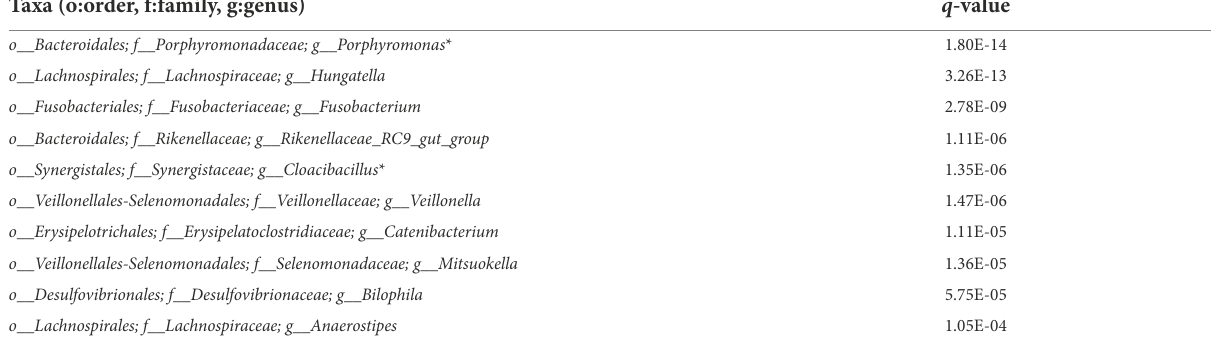
TABLE 5 Top 10 microbiome genera ranked by Cauchy combination